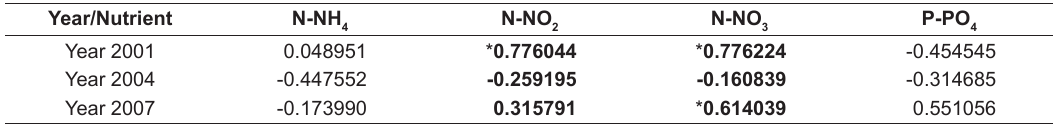
Table 3. Spearman´s nonparametric correlation among nutrients and Chlorophyll -a in the three hydrological years (*significant at p< 0.05).